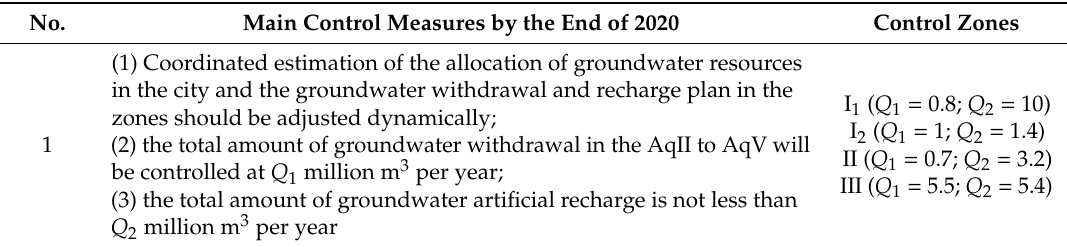
Table 2. Main control measures of each control zones in Shanghai (data from Reference [39]).